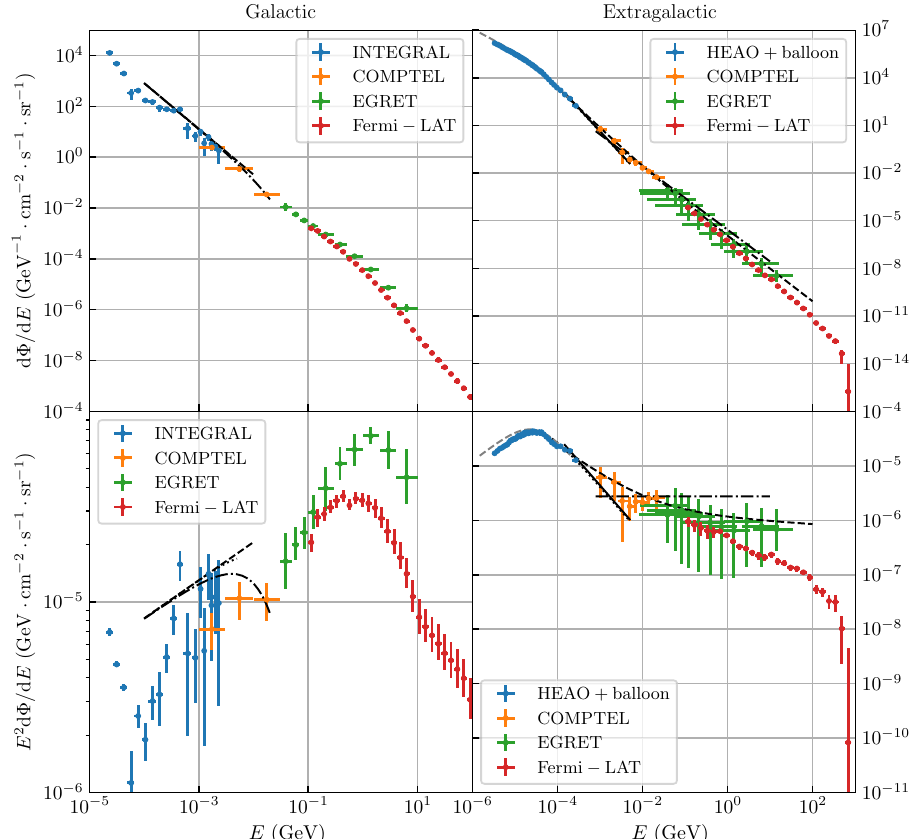
flux measured by HEAO+balloon [71], COMPTEL [72], EGRET [73] and Fermi-LAT [74] (model A). For completeness, we show the follow- ing background models: [71] (dashed, black), [75] (dashed, grey), [76] (dot-dashed), [14] (dotted), [17] (solid). Upper and lower panels show d (cid:9)/ d E and E 2 d (cid:9)/ d E as both representations give useful insight